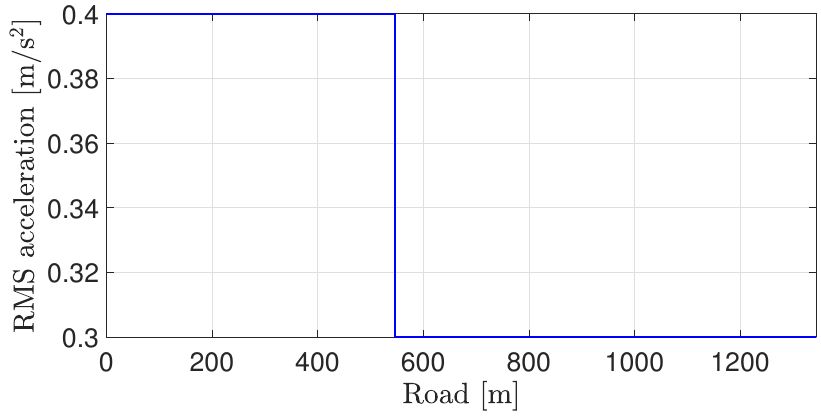
Figure 18. Desired comfort